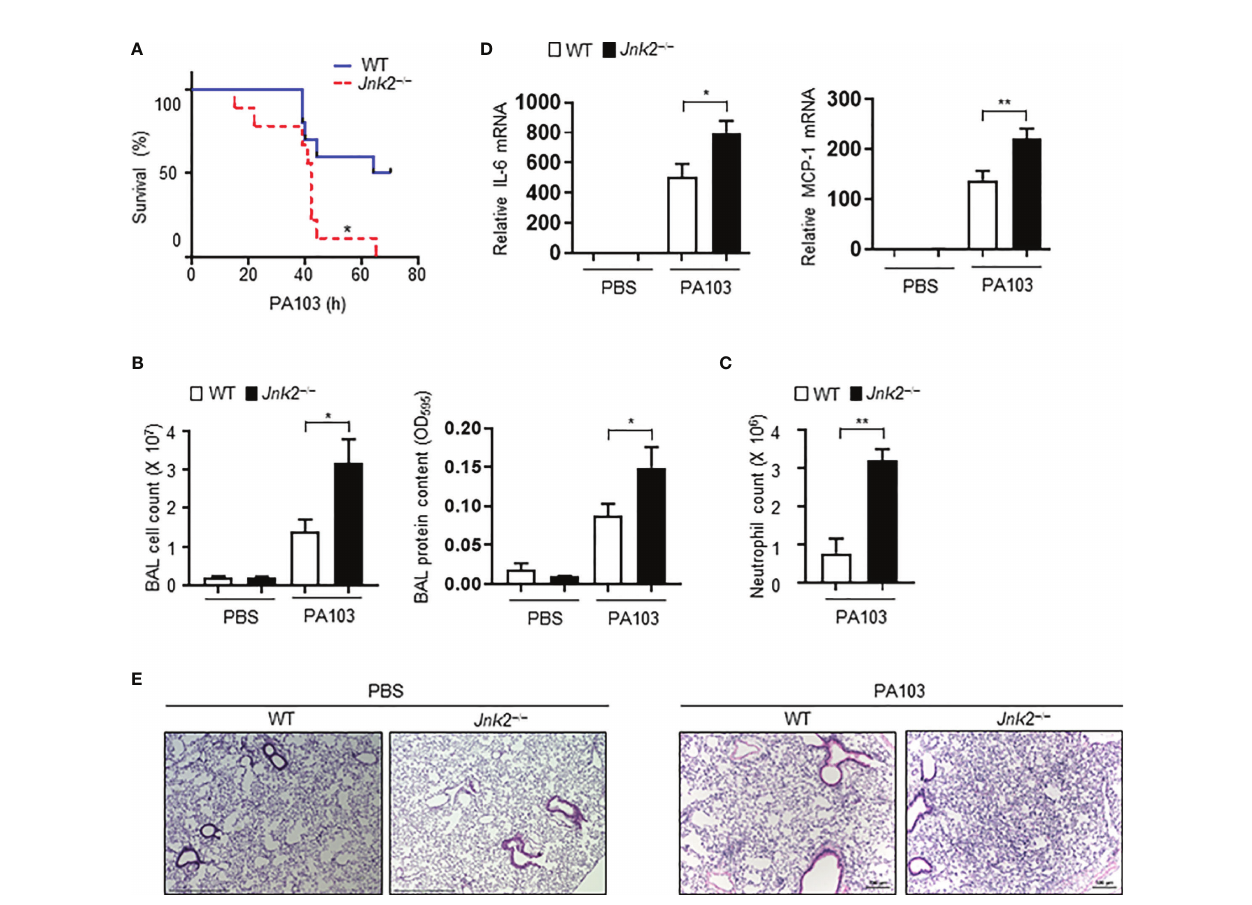
FIGURE 2 | Loss of JNK2 worsens lung in fl ammation and injury during pseudomonas pneumonia. Wild-type and JNK2 KO mice were subjected to i.n. pseudomonas aeruginosa (strain PA103)-induced pneumonia. (A) Mortality of PA103-treated wild-type and JNK2 KO mice. N=9-10. (B – E) Cell count and protein content (B) and neutrophil count (C) in BAL fl uid, and mRNA expressions of in fl ammatory cytokines from whole lung homogenates (D) , or sectional lung histology (E) from PBS- or PA103-treated mice. In (B) , PBS: N=3-8; PA103: N=13-14. In (C) , N=3-4. In (D) , PBS: N=3; PA103: N=4-5. Data are presented as means ± sem. * p < 0.05; ** p <